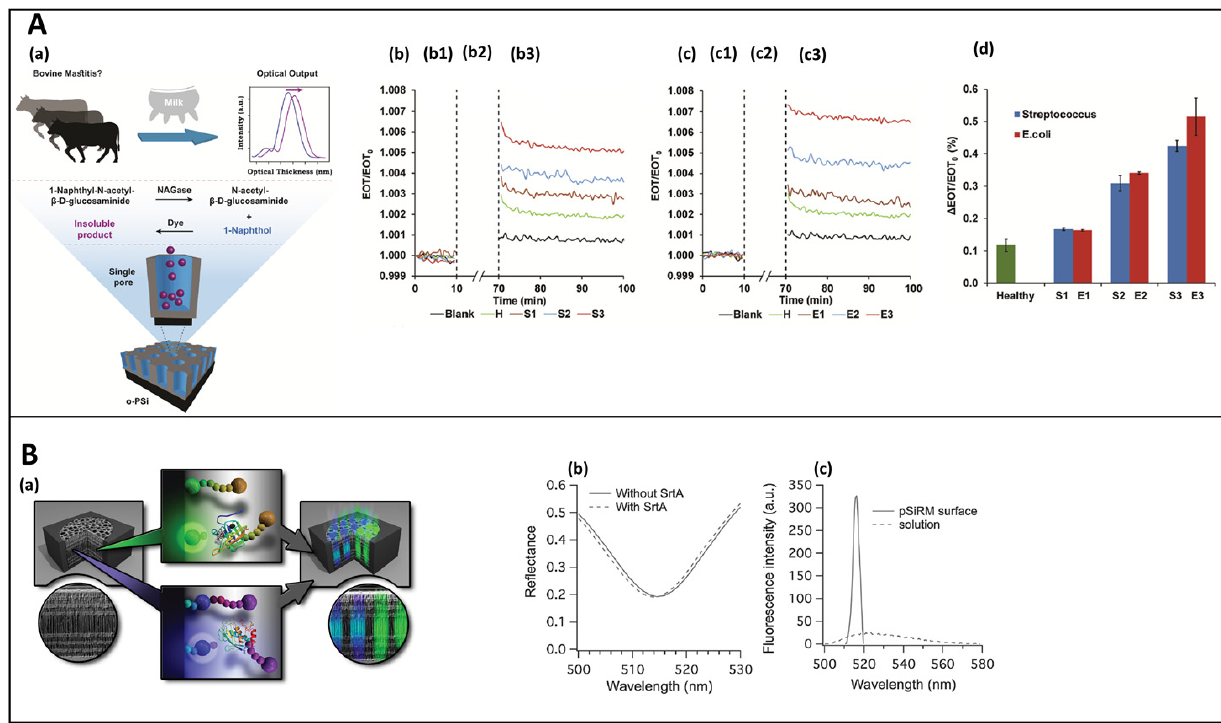
Figure 5. ( A ) (a) Schematic representation of o-PSi biosensor for the NGAse activity detection. The NGAse present in the milk hydrolyzes the NGAse substrate into N-acetyl- β -D-glucosaminide and 1-naphthol. The reaction between 1-Naphthol and Hexazonium Pararosaniline forms an insoluble product that precipitates into the PSi nanostructures causing a change in the reflectivity spectra; (b) reflective-based response of NGAse catalytic activity in milk samples positive to S. dysgalactiae and (c) E. coli . The lines (b1, c1) are the baseline, the reaction solution and the dye are represented by lines (b2, c2) while the buffer wash is represented by lines (b3, c3); (d) averaged optical response obtained by subtracting the blank relative EOT for the corresponding milk samples. Reprinted with permission from Reference [98]; Copyright (2020) American Chemical Society. ( B ) (a) Scheme of a FRET-based PSi biosensor for the detection of SrtA and MMP. The FRET peptide substates are immobilized into a PSi microcavity (central panels). The enzymatic cleavage causes a fluorescence enhancement (right panels); (b)reflectance spectra of PSiRM before and after incubation with SrtA; (c) fluorescence emission of SrtA